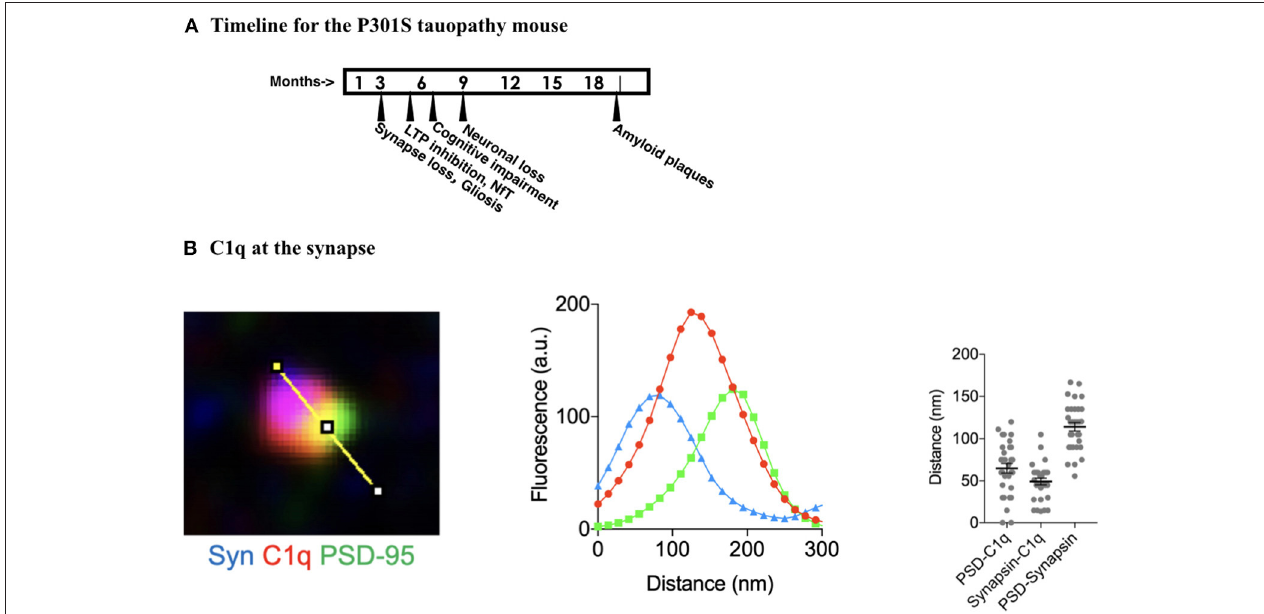
FIGURE 2 | Complement activity at the synapse in the brain of AD tauopathy mice. (A) Timeline for Alzheimer’s Disease signs and symptoms to develop in P301S mouse. This mouse is analogous to a hereditary form of AD with a mutation in the tau gene that is a conversion from proline to serine at amino acid position 301. Timeline information collected from www.Alzform.org. (B) Measurements taken from micrographs of the synaptic region of the P301S mouse hippocampal CA1 region where neuronal structure is disrupted, at nine months. Data from Dejanovic et al. (2018) with permission. Fluorescence recordings from Synapsin at the presynaptic membrane, C1q, and PSD95 at the post-synaptic membrane. Analogous samples from the hippocampal CA1 region of mice without the P301S addition showed C1q staining that was barely detectable, indicating that the C1q location and increased density was due to the AD like pathology in the P301S